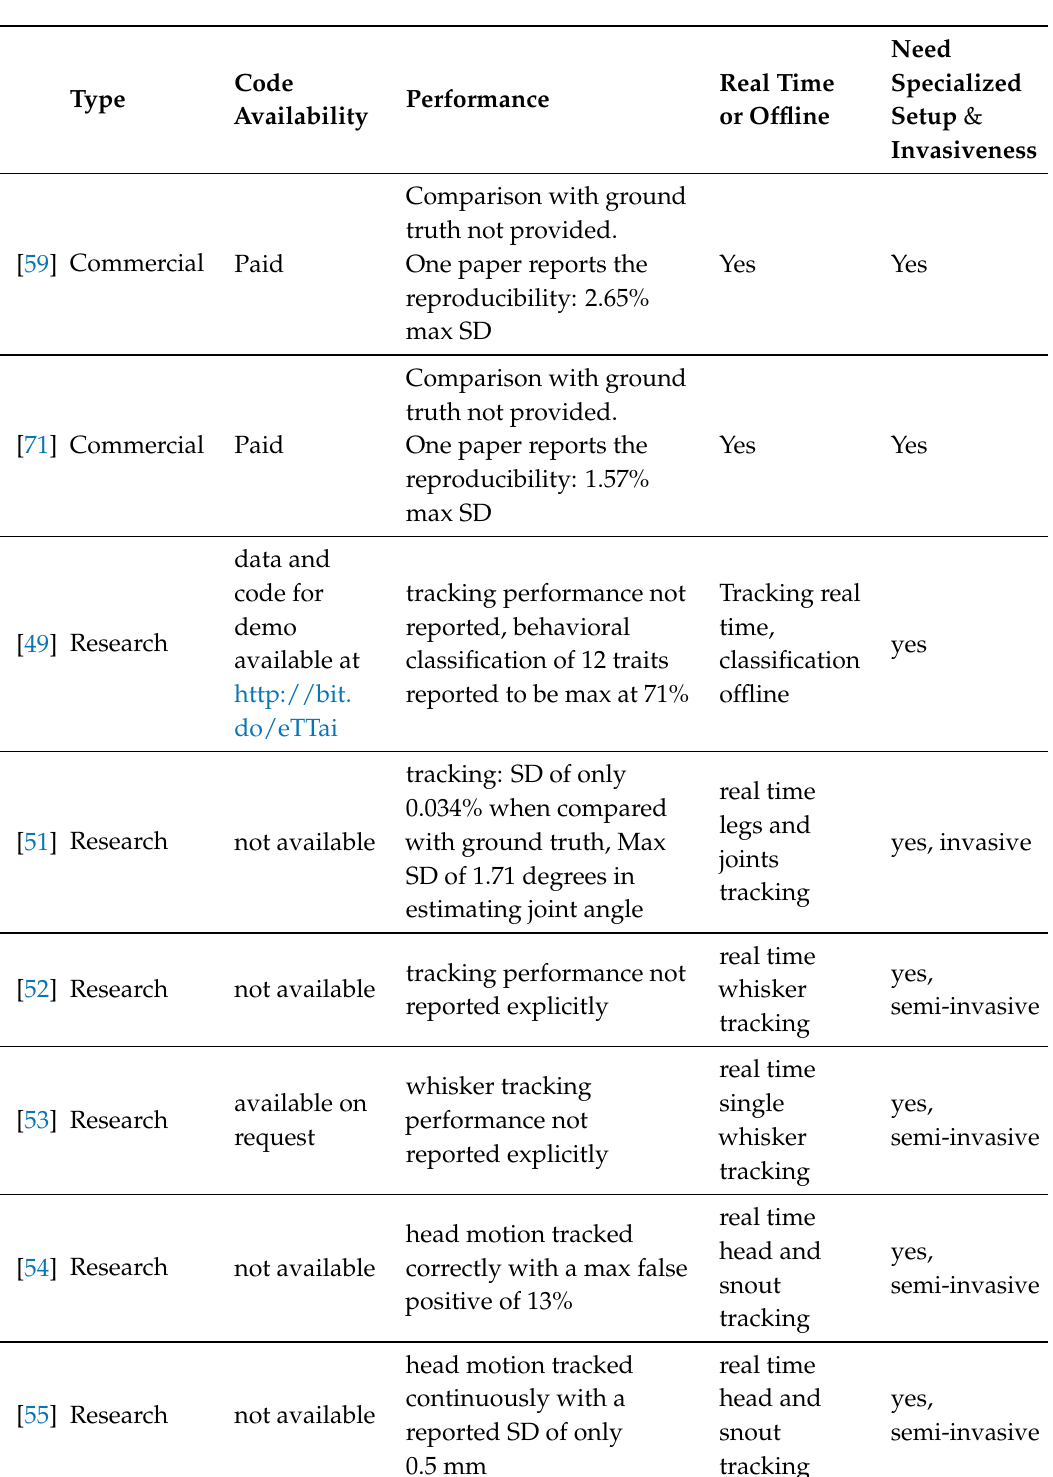
Table A1. Comparison of different approaches. Legend:: Invasive: Approaches which requires surgery to put markers for tracking, semi-invasive: Approaches which do not need surgery for marker insertion, non-invasive: no marker needed. Real time means that the system can process frames at the same rate they are being acquired. If it needs specialized equipment apart from standard video cameras and housing setup, it is pointed out in the last